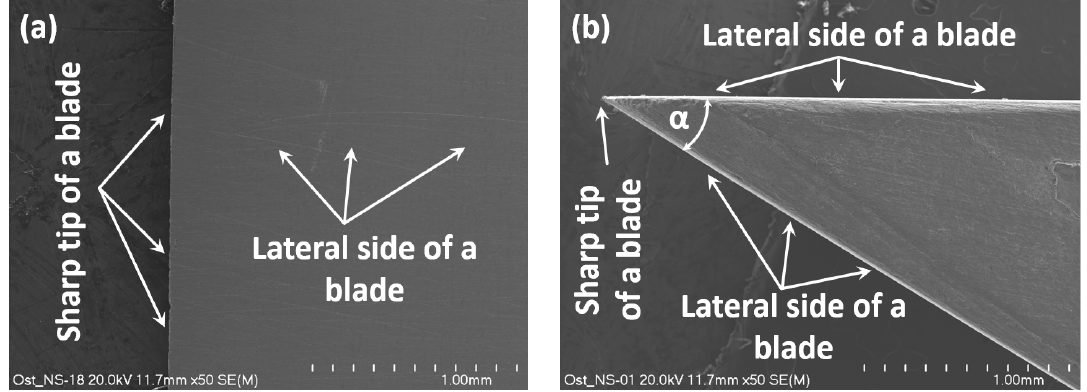
Figure 6. The blade of a cutting tool under magnification × 50; view from the lateral side ( a ) and from the front ( b ).